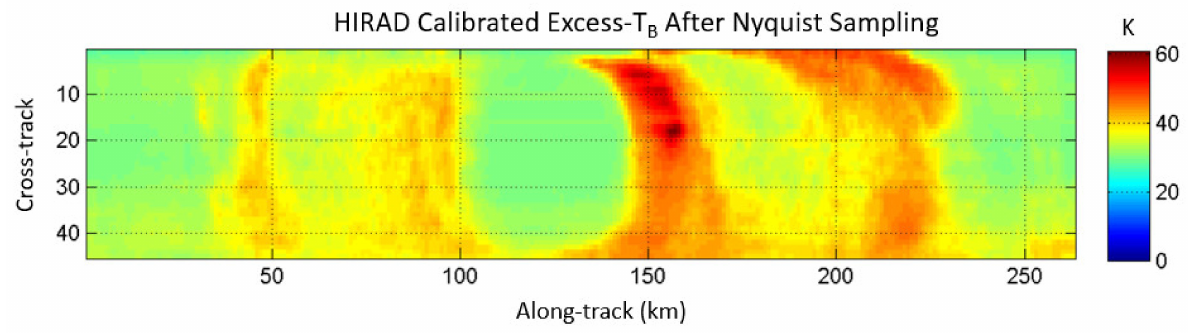
Figure 10. HIRAD Leg 4, channel 5, calibrated excess T B data after combining sub-bands and Nyquist